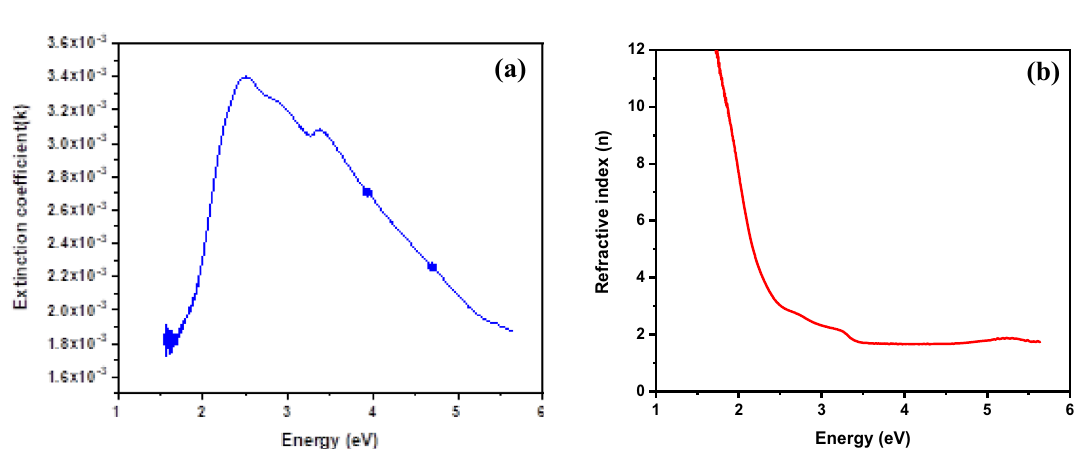
Figure 6. ( a ) Variations in the extinction coefficient ( k ) and ( b ) variations in the refractive index ( n ) as a function of energy for Zn–Fe